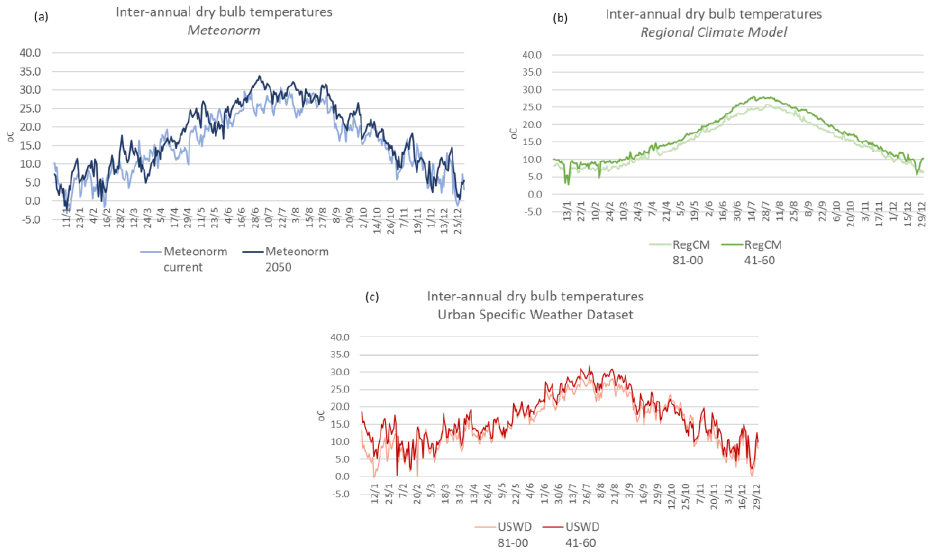
Figure 8. Inter-annual daily Tair evolution for the present-day and the future weather datasets generated ( a ) with Meteonorm weather generator, ( b ) with the output of the RegCM model and ( c ) with the proposed computational method that considers both climate change and local microclimate